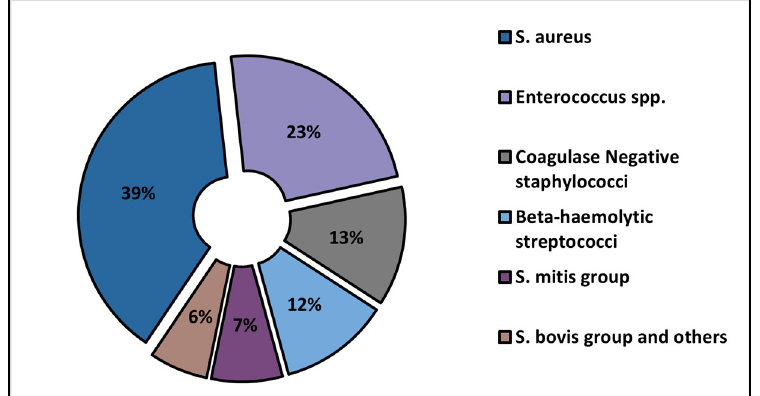
Figure 1. The proportion of Gram-positive bacteria identified.